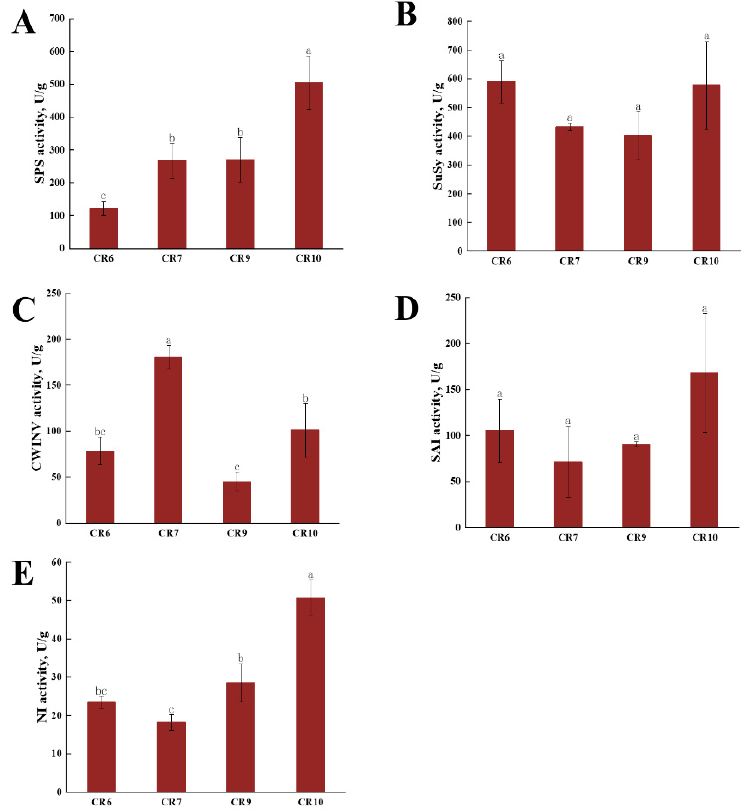
Figure 2. Activities of key enzymes involved in fruit sugar metabolism at different developmental stages. ( A – E ) Activity of sucrose phosphate synthase (SPS), sucrose synthase (SuSy), cell wall acid invertase (CWINV), soluble acid invertase (SAI), and neutral invertase (NI), respectively. Significant differences ( p < 0.05) are indicated by lower case letters. Letters are arranged alphabetically starting from the highest values with similar letters indicating no significant difference. All error bars depict SD of the mean (n ≥ 3).